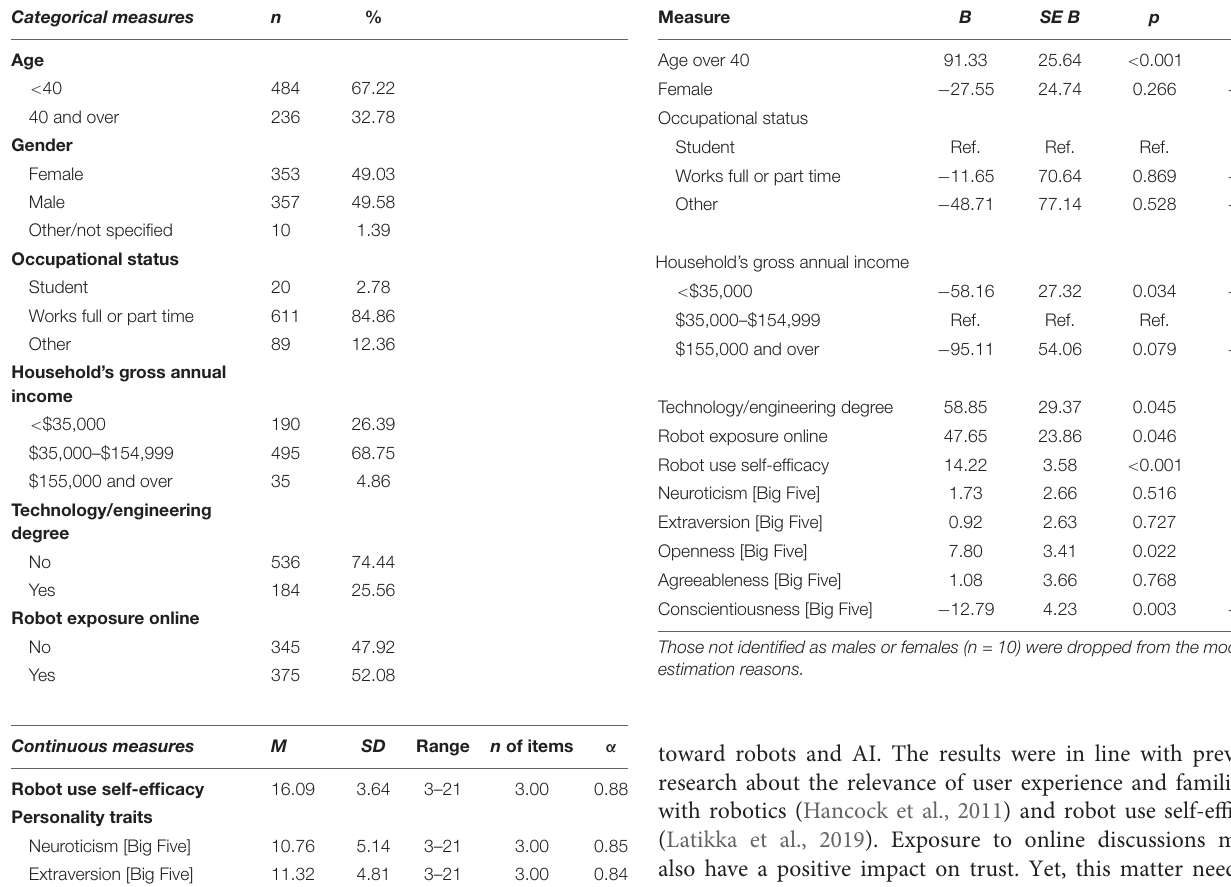
TABLE 4 | Linear regression analysis on money given to an AI or a robot opponent ( N =